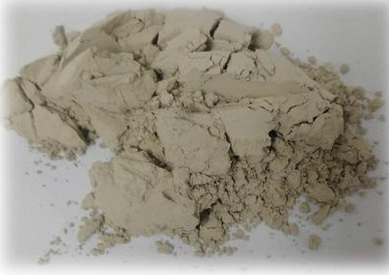
Figure 1. Cement bypass dust